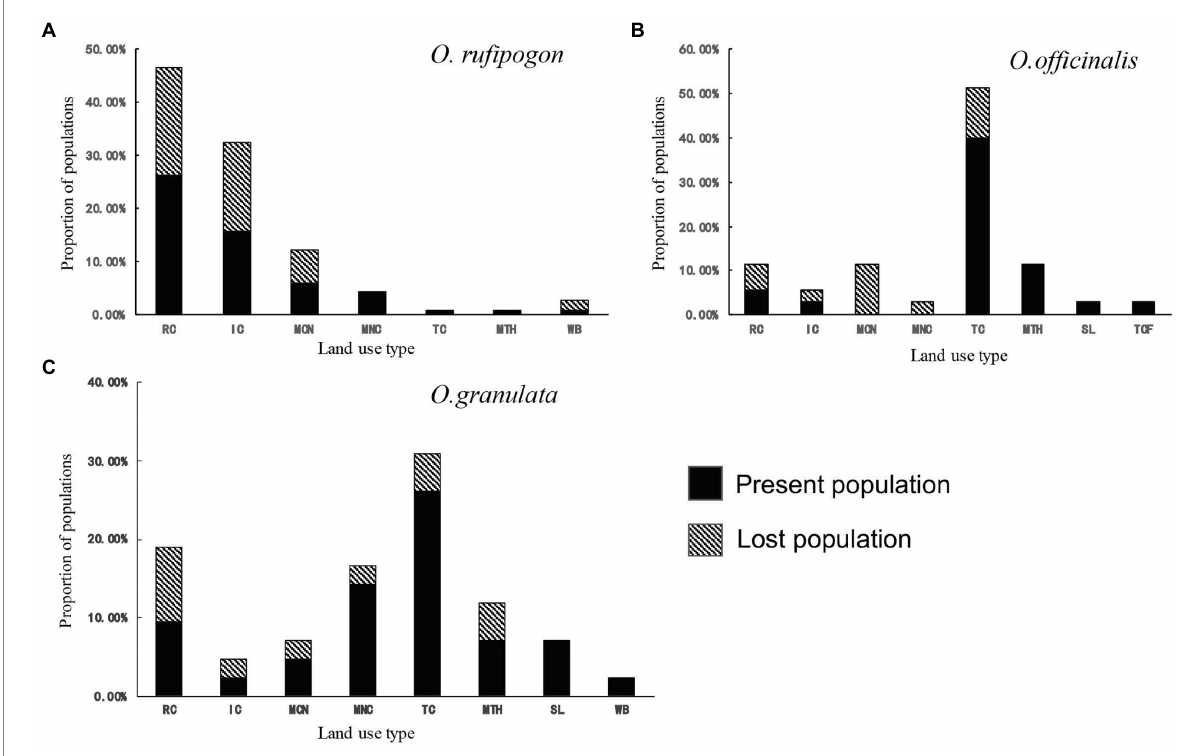
FIGURE 2 Population proportion per land use type of (A) O. rufipogon (B) O. officinalis (C) O. granulata during 2001~2019. Present population is the population survived during 2001~2019; Lost population presented in 2001 but disappeared in 2019. RC, rainfed cropland; IC, irrigated or postflooding cropland; MCN, mosaic cropland, >50% / natural vegetation, <50%; MNC, mosaic natural vegetation, >50% / cropland, <50%; TC, tree cover; MTH, mosaic tree and shrub, >50% / herbaceous cover, <50%; SL, shrubland; TCF, tree cover, flooded, fresh, or brackish water; WB, water